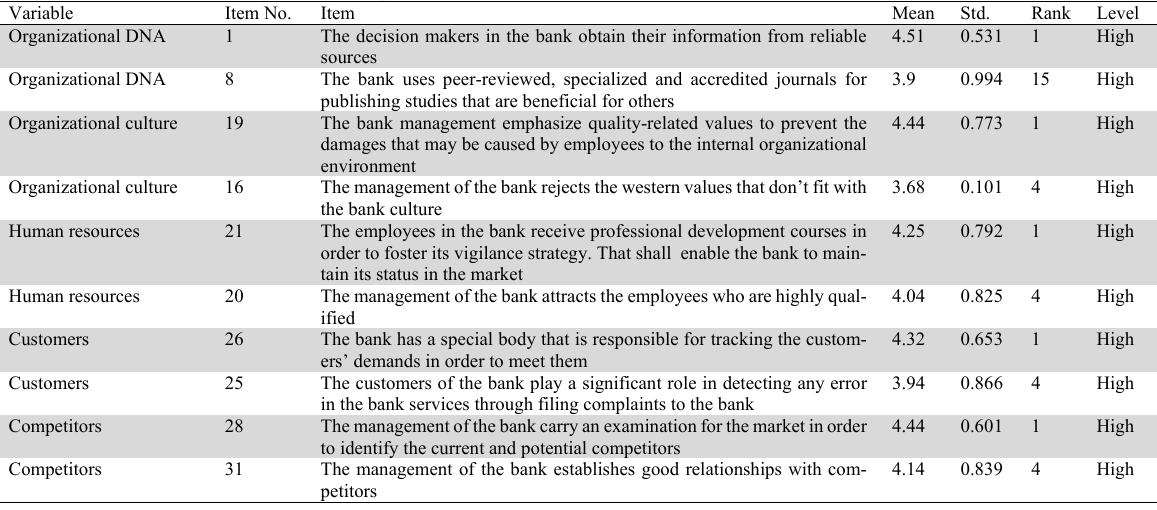
Organizational DNA: Based on table (4), the mean of statement (1) is ranked first. It is 4.51. The standard deviation of the latter statement is 0.531. The mean of statement (8) is ranked last. It is 3.9. The standard deviation of the latter statement is 0.994. Means and standard deviations of the respondents’ attitudes